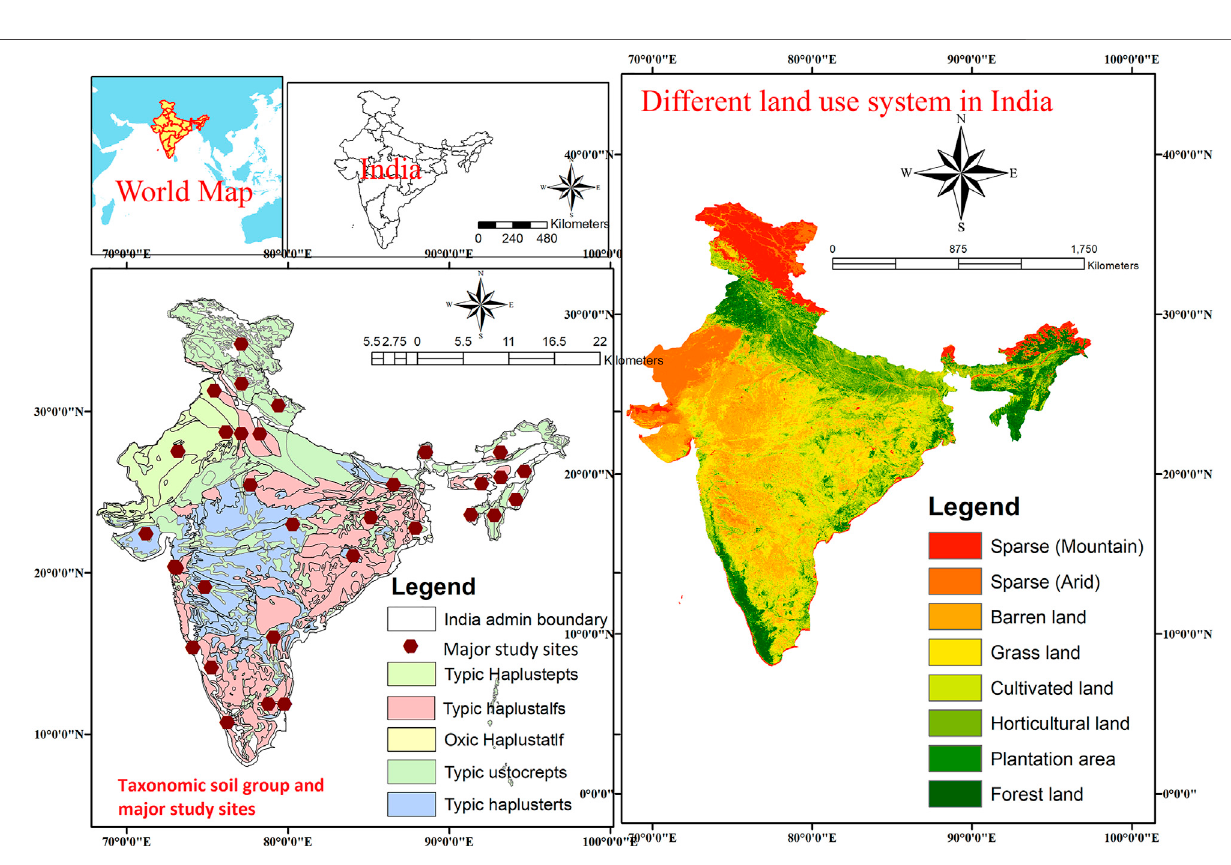
Frontiers in Environmental Science |